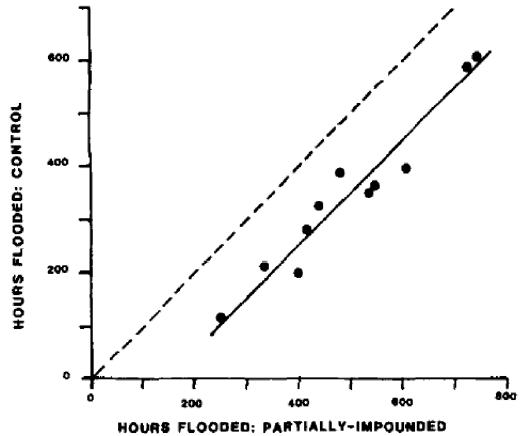
Figure 8. Total hours flooded, for one month, at a reference marsh with a natural berm and a partially impounded area where about 75% of the natural berm had been replaced by a dredged canal spoil bank, Golden Meadow oil and gas field south of New Orleans, LA [52]. The dashed line shows what the relationship would be if there were no partial impoundment.